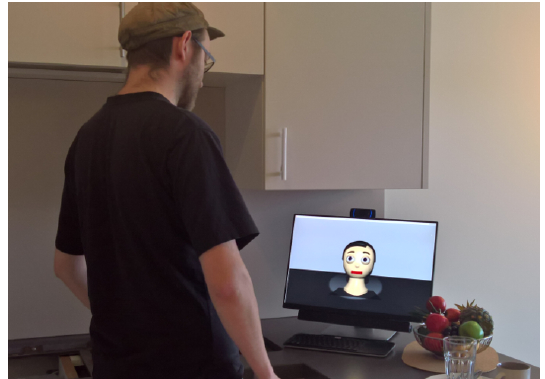
Figure 3. Person being instructed by virtual agent on a screen.